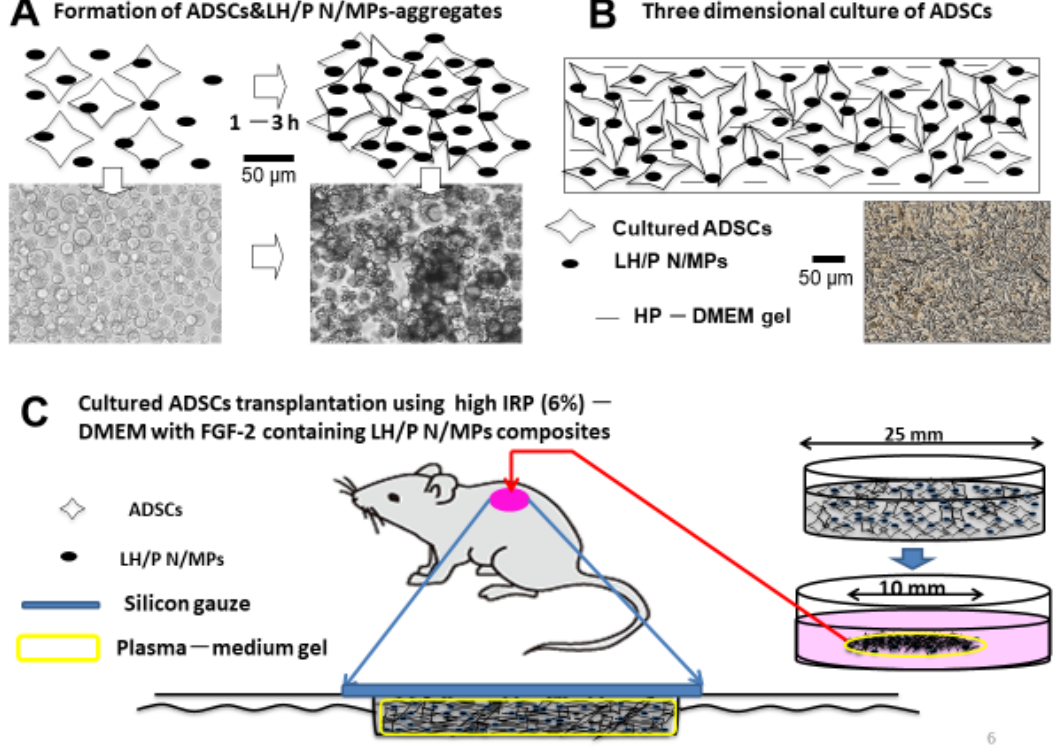
Figure 5. ( A ): Generation of adipose-derived stromal cells (ADSC)-aggregates. ( B ): Three-Dimensional (3D) culture. ( C ): Transplantation of 3D-cultured ADSCs.